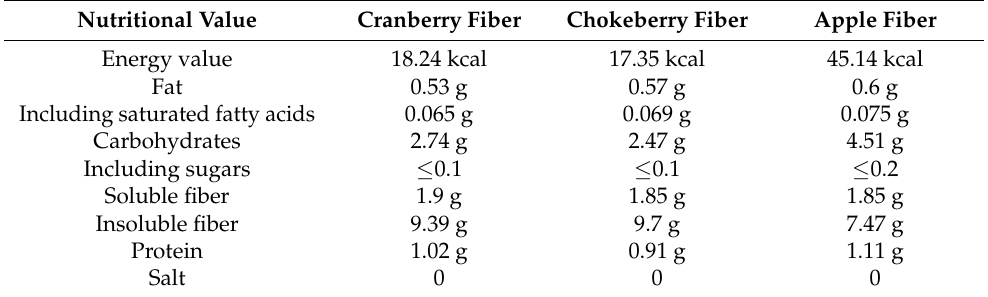
Table 1. Nutritional value-composition of basic nutrients in fruit-origin additives (fruit fibers). Nutritional